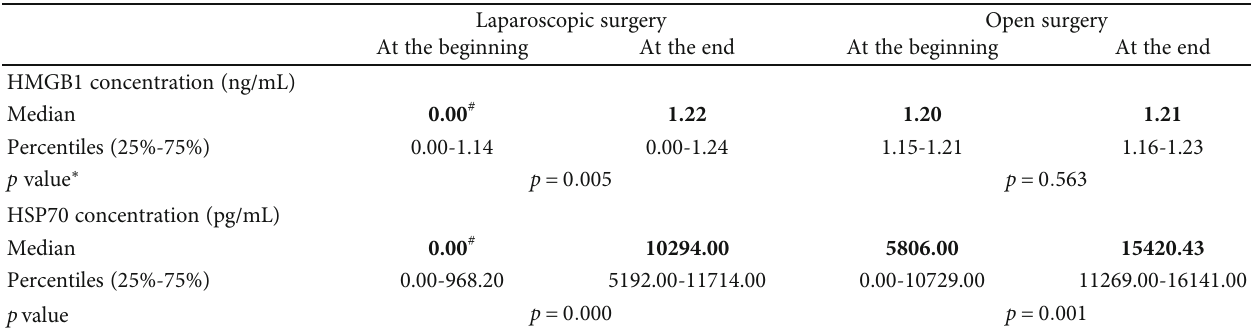
Table 3: HMGB1 and HSP70 concentration in peritoneal lavage fl uid of children at the beginning and at the end of laparoscopic and open cholecystectomy.